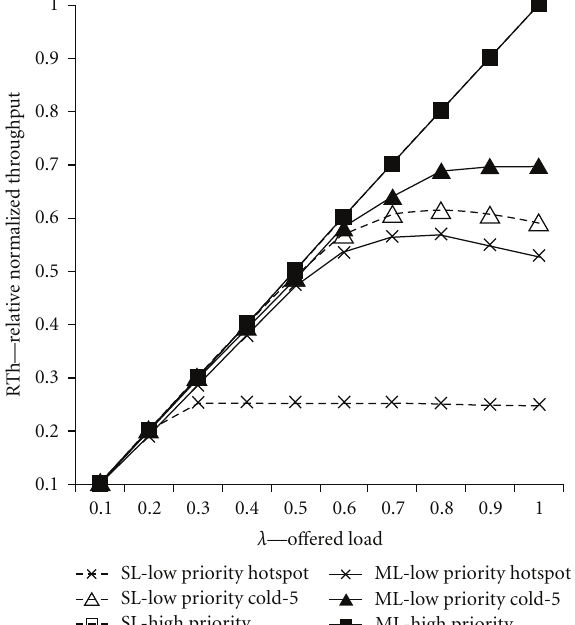
Figure 7: Normalized delay of a dual-priority, double-bu ff ered, 6- stage MIN under hotspot tra ffi c at a multilayer